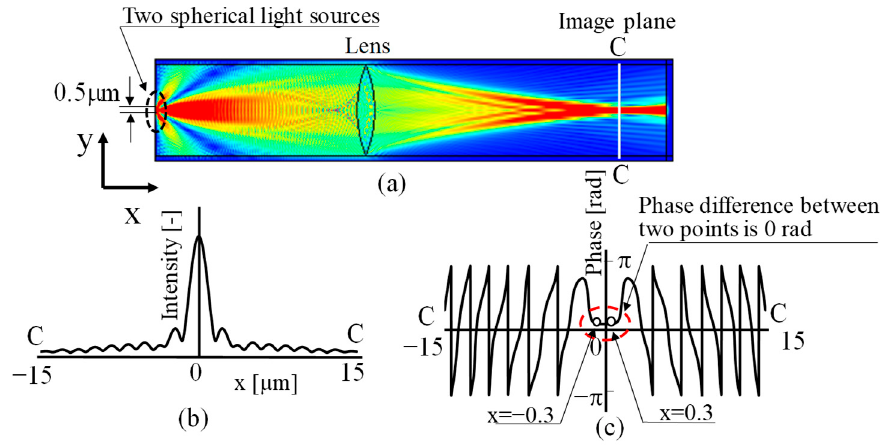
Figure 6. Simulated results when two light sources are set closer than the Rayleigh criterion. ( a ) Electromagnetic fi eld simulation result. ( b ) Intensity distribution in section C-C. ( c ) Phase distribution in section C-C.